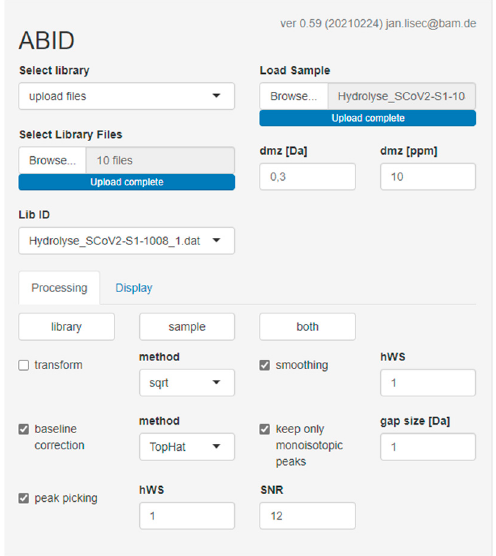
Figure 11. Screenshot of the graphical user interface of the ABID 2.0 software. Antibody fingerprints are stored or uploaded and processed to generate a spectra library. This library can then be compared to an independent spectrum (“Load Sample”). Several processing parameters can be changed to improve the matching, for example, for noisy spectra.